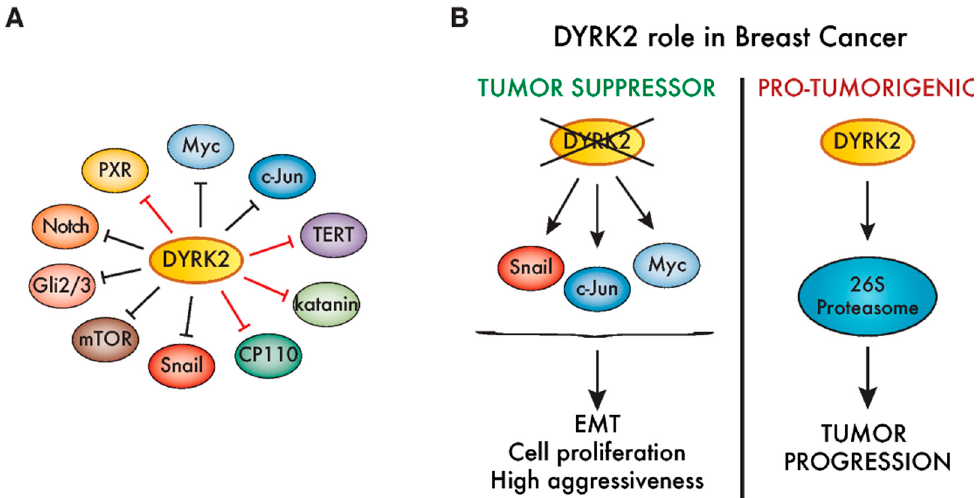
Figure 5. Cancer-associated activities of DYRK2. ( A ) DYRK2 substrates are associated with different aspects of tumorigenesis, including proliferation (Myc, c-Jun, centrosomal protein of 110 kDa (CP110) and katanin: [38,56]); transformation (TERT: [154]); invasiveness (Snail: [141]); signaling (mTOR, Notch and Gli2/3: [34,64,155]) or the xenobiotic response system (pregnane X receptor (PXR): [156]). Red lines mark those substrates that are degraded when DYRK2 associates with the multicomponent E3 ubiquitin ligase EDVP. The rest (black lines) are all targets of FBXW7, considered to be a tumor suppressor [157]. ( B ) DYRK2 has been proposed as both a protumorigenic factor, as well as a tumor suppressor, in breast cancer. On the one hand, reduced levels of DYRK2 enhance the accumulation of mitogenic transcription factors like c-Jun and Myc, as well as the epithelial-to-mesenchymal transition (EMT)-promoting factor Snail, which is correlated with tumor progression and more aggressiveness. On the other hand, DYRK2 phosphorylates and positively regulates the 26S proteasome, promoting triple-negative breast cancer (TNBC) cell growth, and thus, DYRK2 depletion or inhibition impairs tumor growth in vivo.